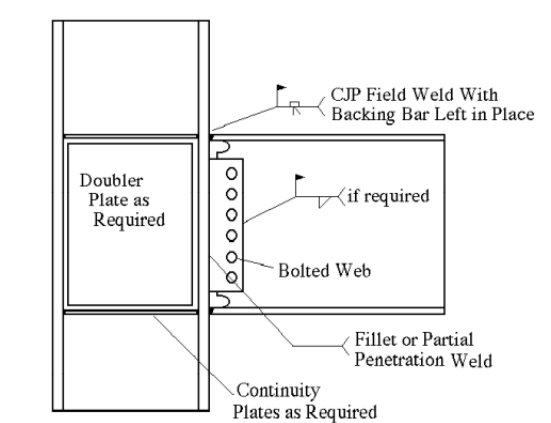
Fig. 1 . Fully Restrained Weld-Flange-Bolted-Web Connection